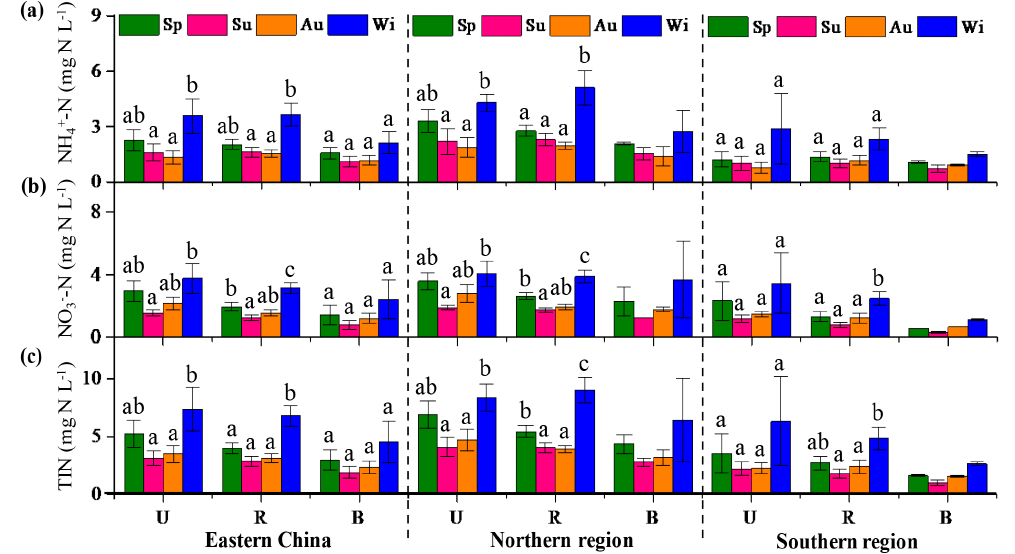
Figure 4. Seasonal mean concentrations averaged over 2011–2015 of NH + (c) , in precipitation at different land use types in eastern China and its northern and southern regions. Sp, Su, Au, and Wi represent and NO − 3 spring, summer, autumn, and winter respectively. U, R, and B denote urban, rural, and background sites respectively. The number of sites for each land use type in each region can be found in Table 1. The error bars are the standard errors of means, and values without same letters on the bars denote significant differences between the seasons ( p <0.05).